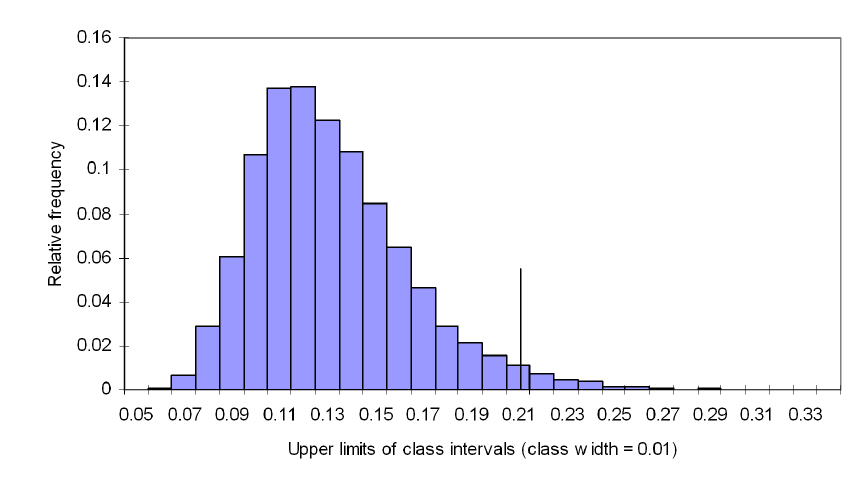
Figure 3: Histogram of largest C p influence measures in 10 000 bootstrap